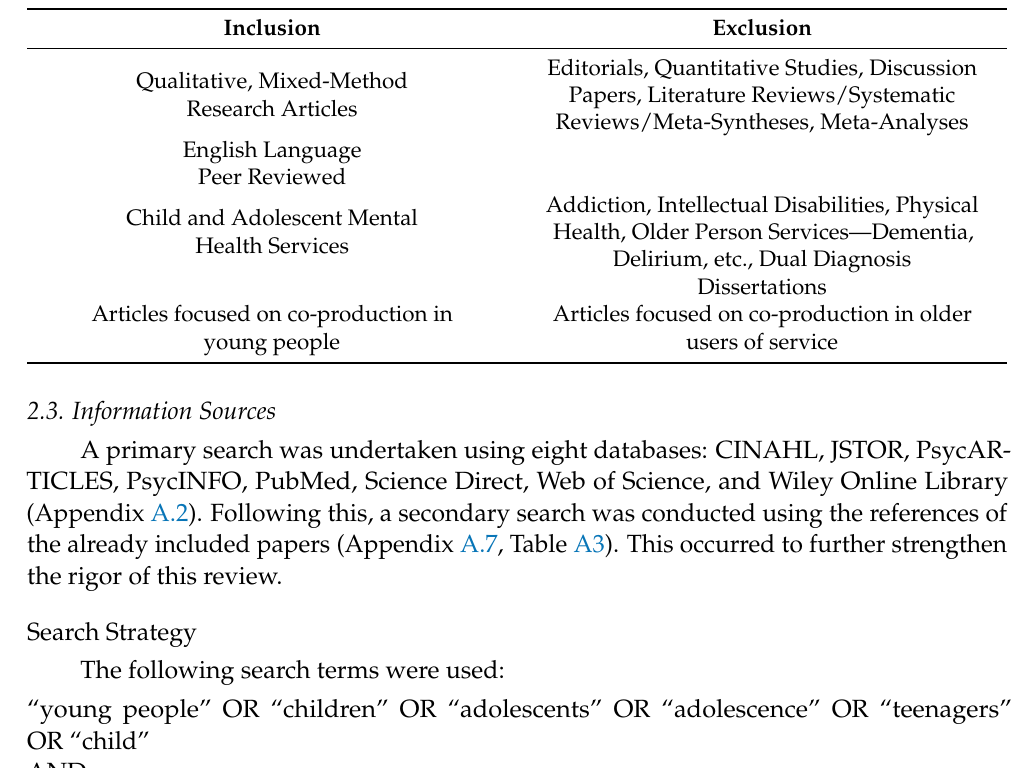
Table 1. Inclusion/exclusion